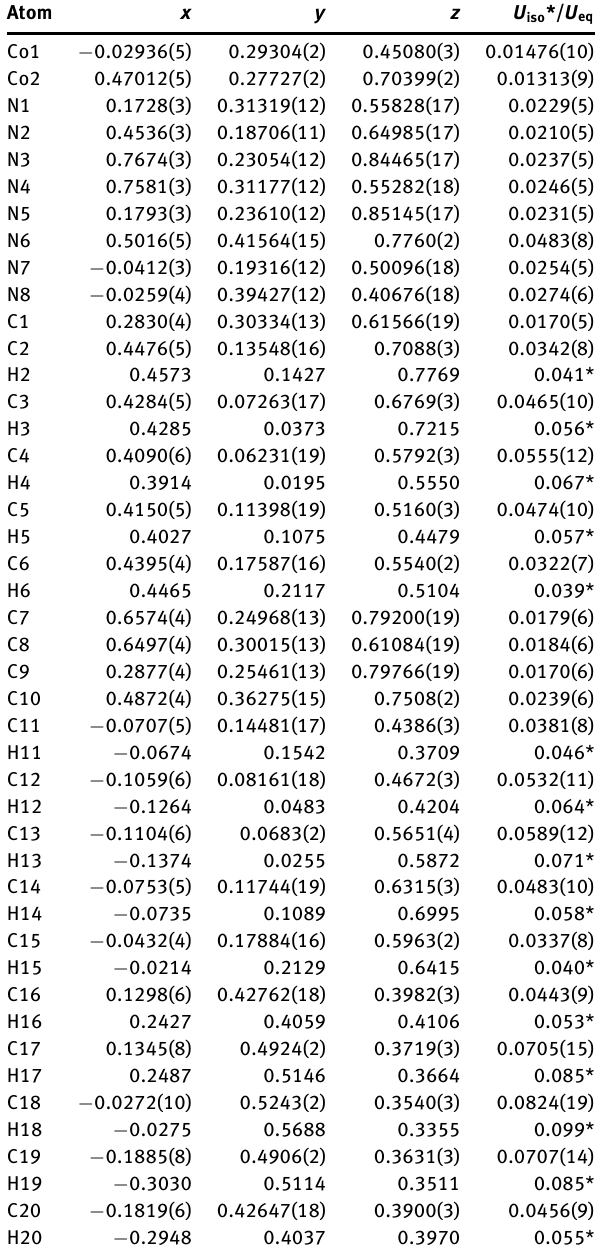
Table 2: Fractional atomic coordinates and isotropic or equivalent isotropic displacement parameters (Å 2